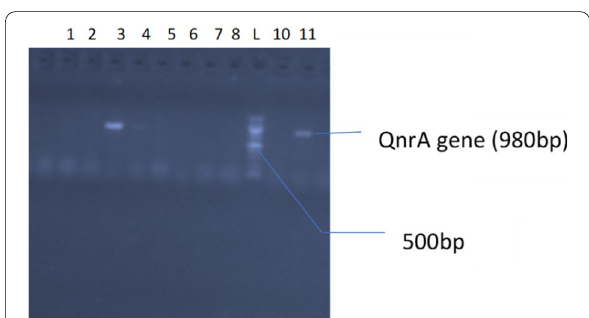
Fig. 2 A representative of the agarose gel electrophoresis of qnrA